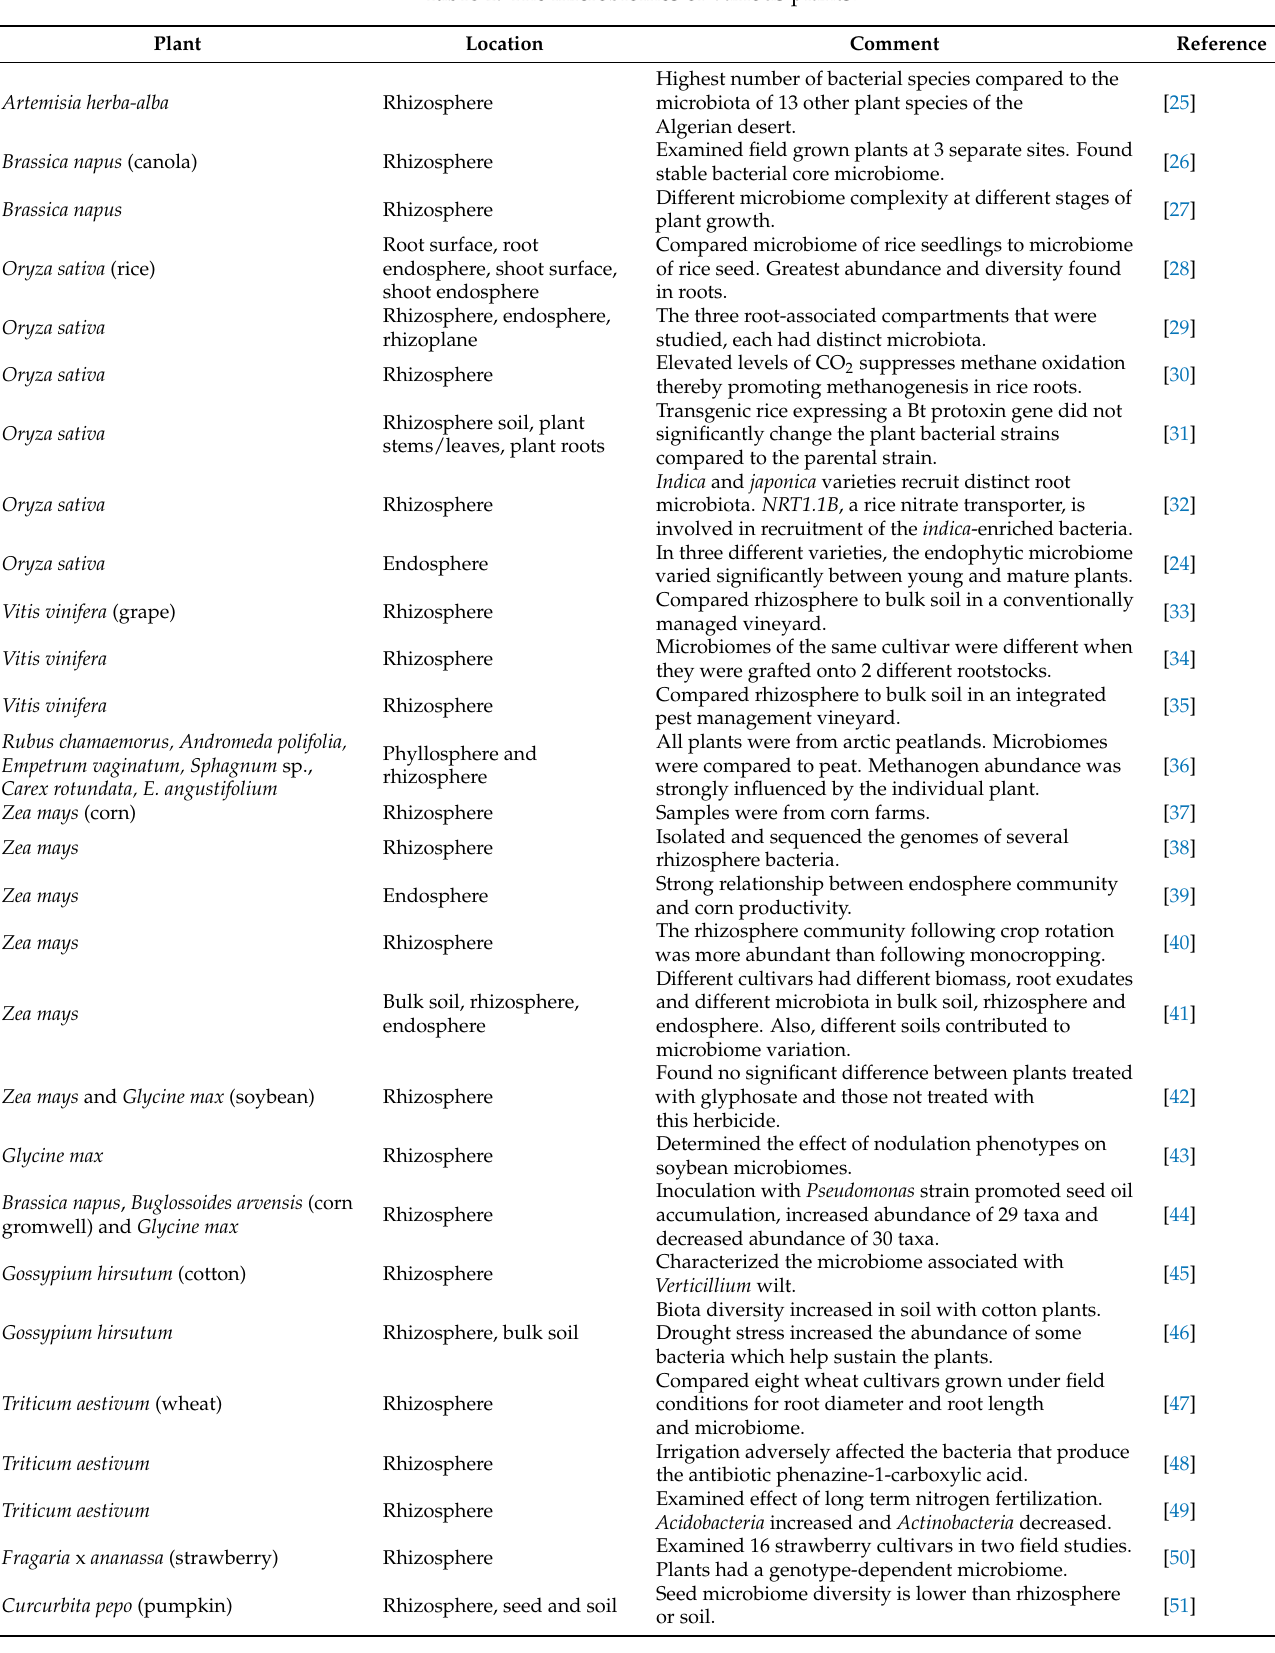
Table 1. The microbiomes of various